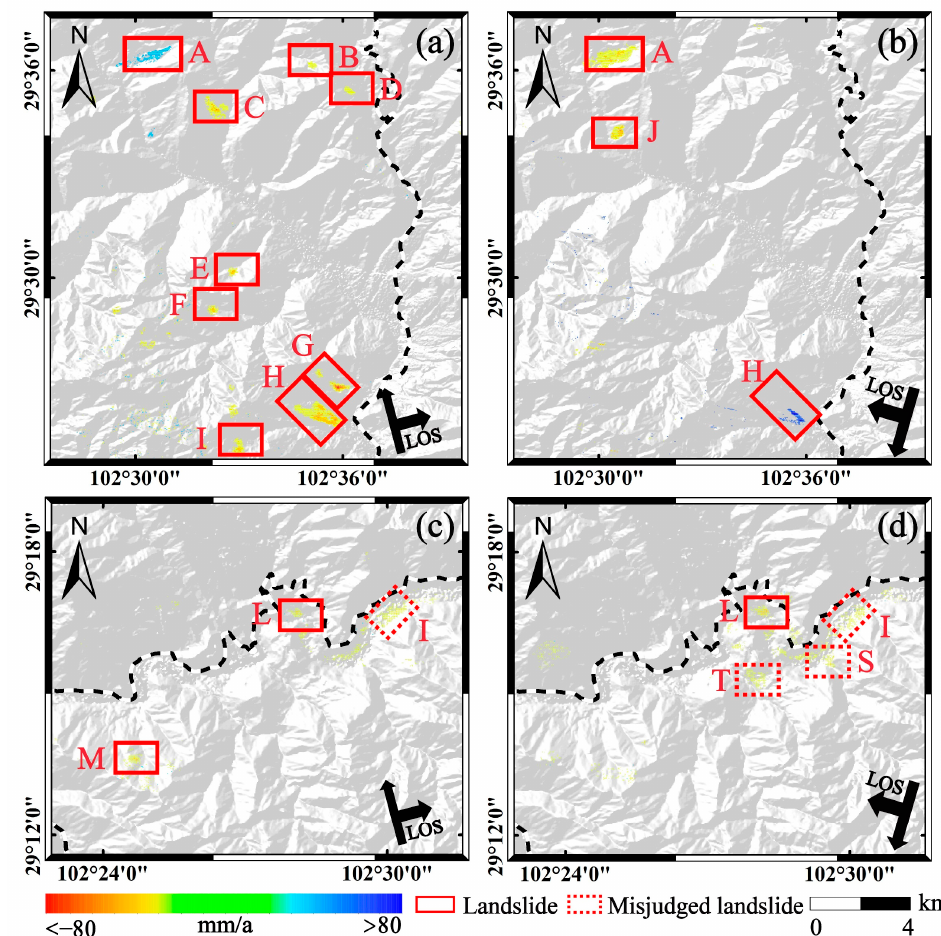
Figure 8. Hotspot analysis results: ( a , b ) represent hotspot analysis results of Zone 1 from ascending and descending tracks, respectively, and ( c , d ) represent hotspot analysis results of Zone 2 from ascending and descending tracks,